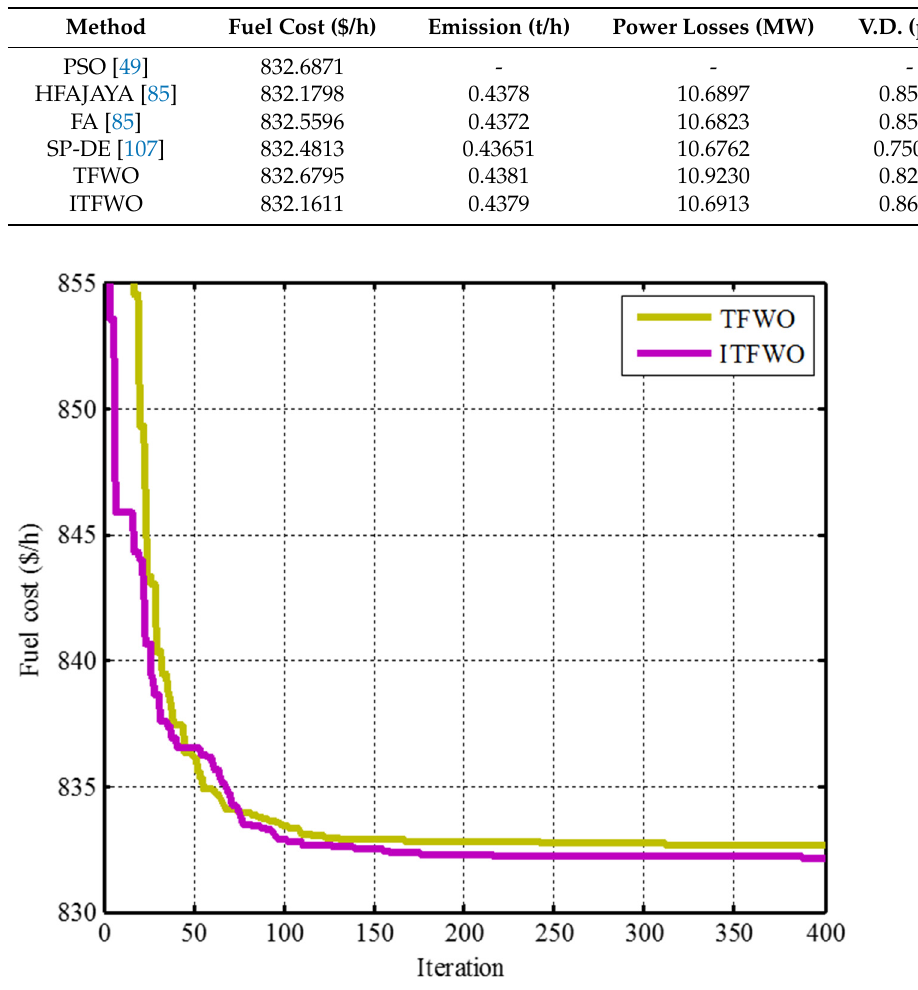
Table 6. The simulation solutions for Type 5.